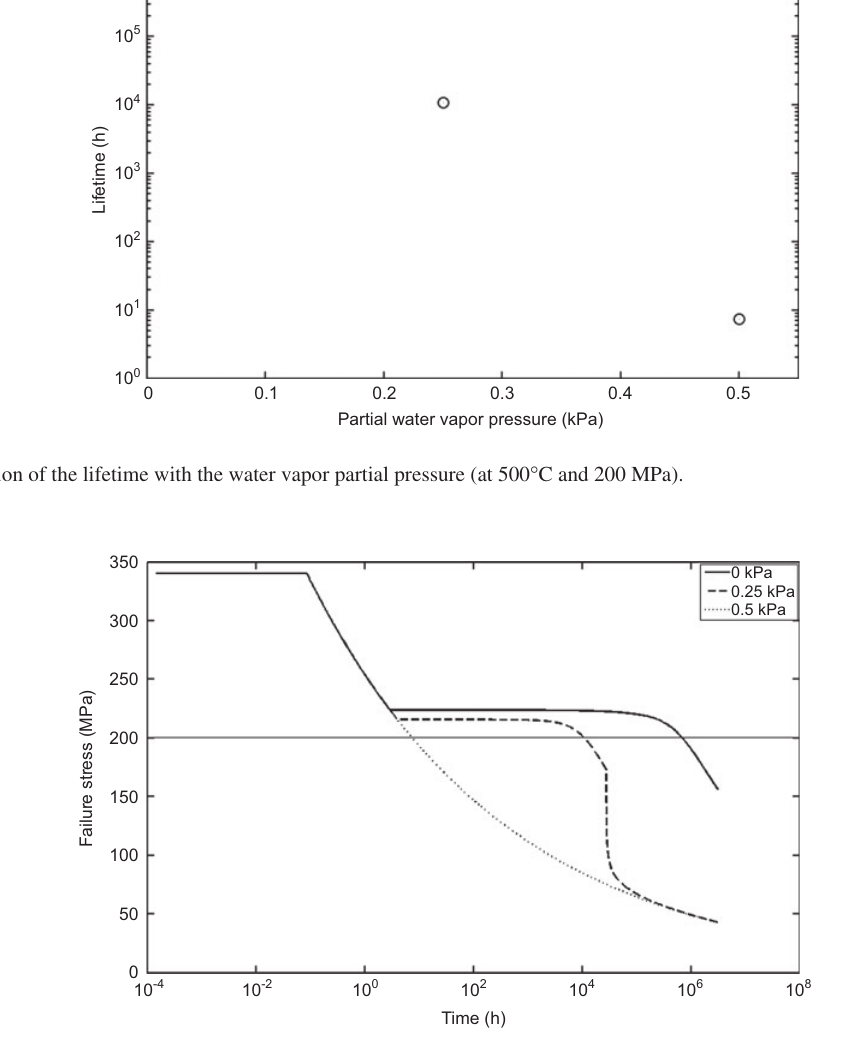
Figure 6 Failure stress as a function of time (at 500 ° C and 200 MPa) for various water vapor partial